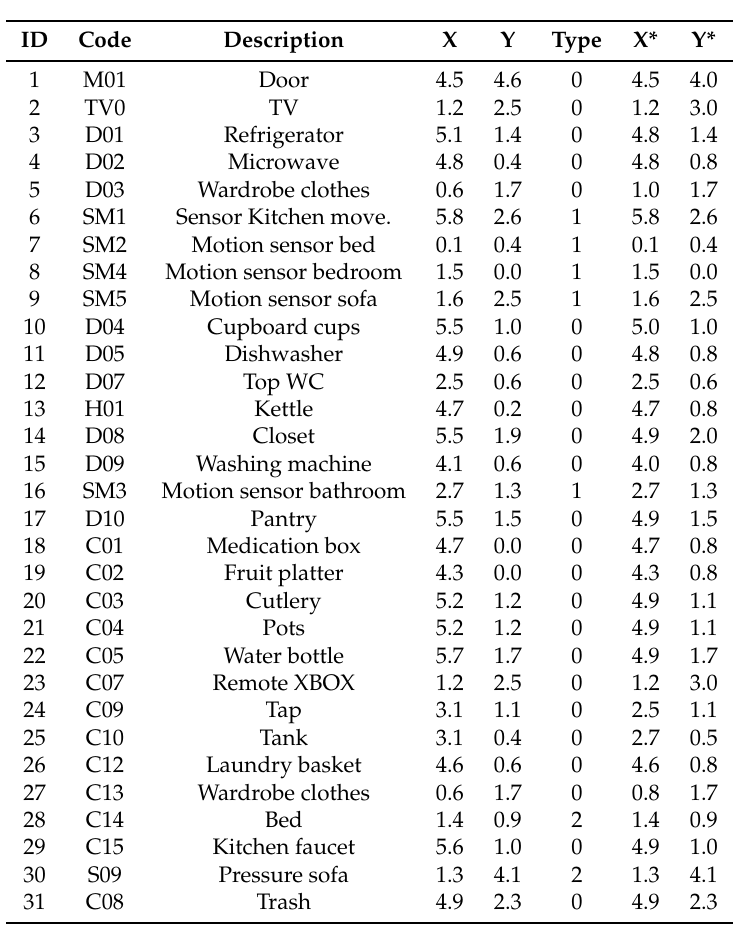
Figure 1. UJAmI SmartLab at Jaén University 3D model ( Left ). Deployment of BLE beacons for localization ( Right ) and smartfloor module distribution. Table 1. Binary sensors in the deployment (coordinates in